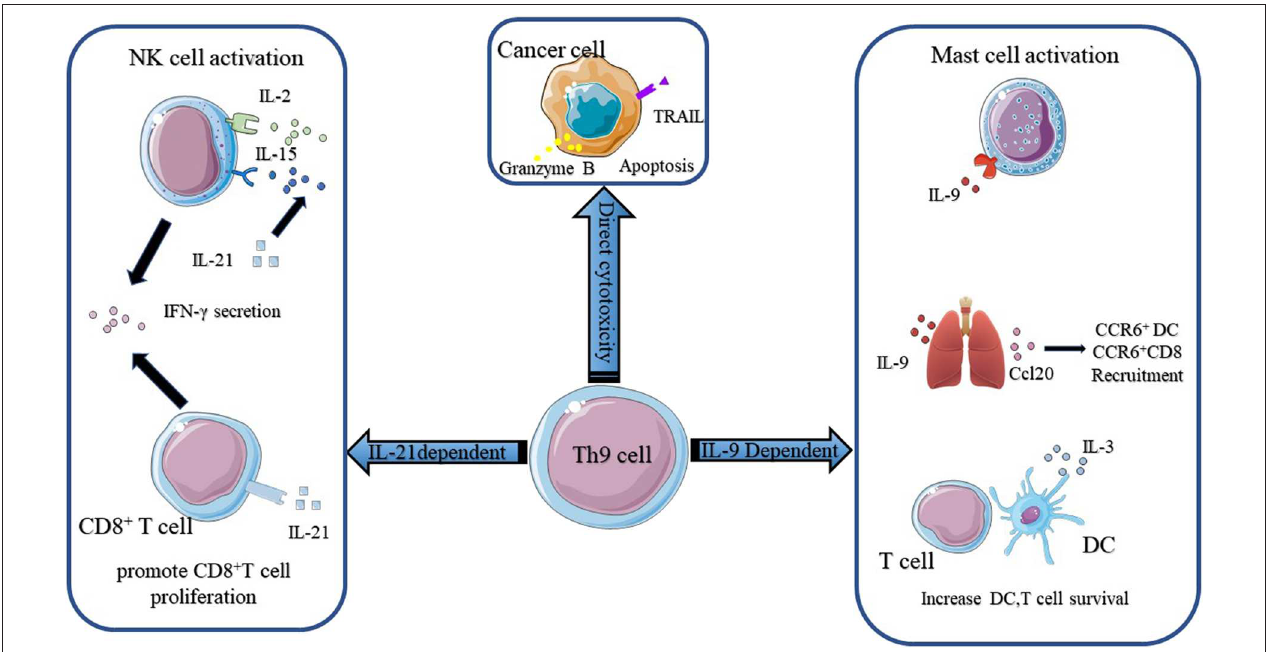
FIGURE 2 | The mechanisms of Th9 cells in anti-tumor immunity. The anti-tumor function of Th9 cells mainly relies on IL-9 and IL-21. IL-9 activates mast cells and enhances their cytotoxic capacity. IL9 also activates epithelial lung cells to produce CCL20, which attracts CCR6 + DC and CCR6 + CD8 + T cells into the tumor bed. Besides, IL-9 increases DC and T cell survival. Th9 cells derived IL-21 promotes CD8 + T cell proliferation and increases NK cytolytic functions. IL-21 also induces NK and CD8 + T cells secretion of IFN- γ . Figures were produced using Servier Medical Art